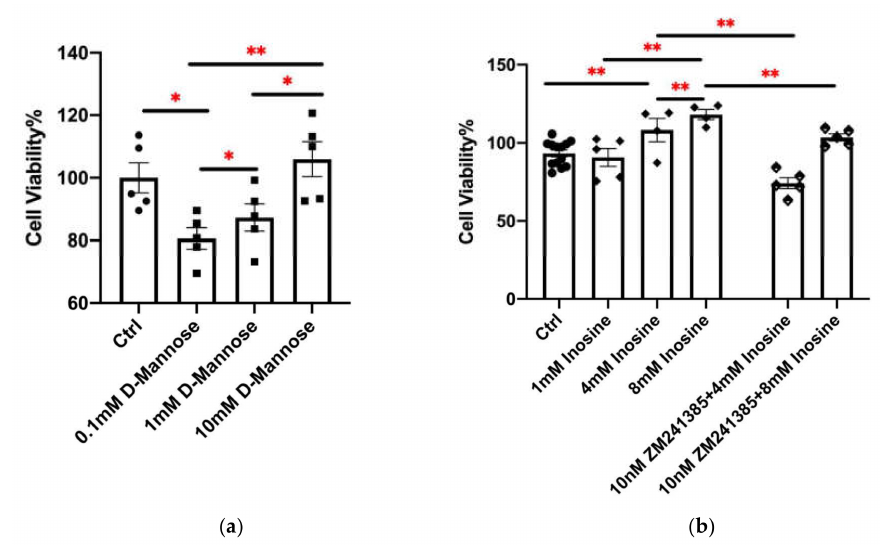
Figure 5. The effects of inosine and D-mannose on A549 cell viability after 3 h stimulation. ( a ) A549 cell viability was evaluated after treatment with inosine at various concentrations (1, 4, 8 mM), with or without pre-treatment with 10 nM ZM241385 for 0.5 h. ( b ) A549 cell viability was evaluated after treatment with D-mannose at various concentrations (0.1, 1, 10 mM) for 3 h. Y -axis represents cell viability. (*, p < 0.05, **, p < 0.01, Mean ± SE; Data analyzed by the Student’s t -test. The experiments were performed in